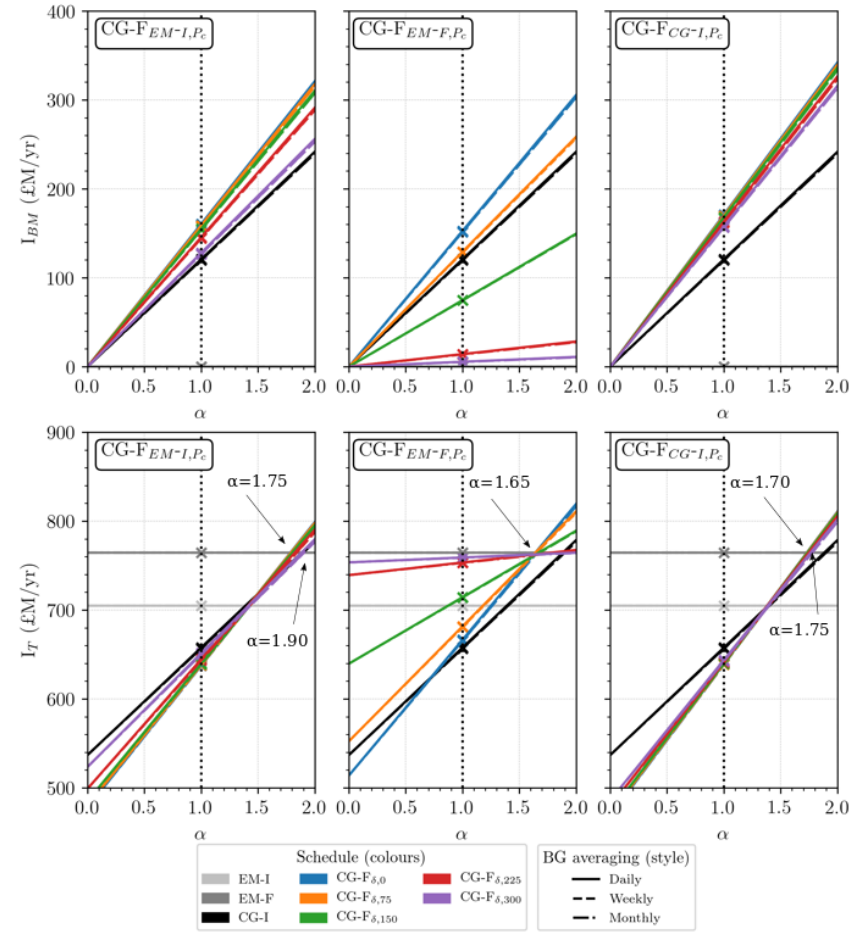
Figure 10. How scaling α of the Baseload Market electricty price p ( t ) BM (£/MWh) affects income both exclusively in the Baseload Market (BM), and in combination with the Hourly Variable Market (HVM). l-r is δ = EM-I, δ = EM-F, and δ = BG-I default